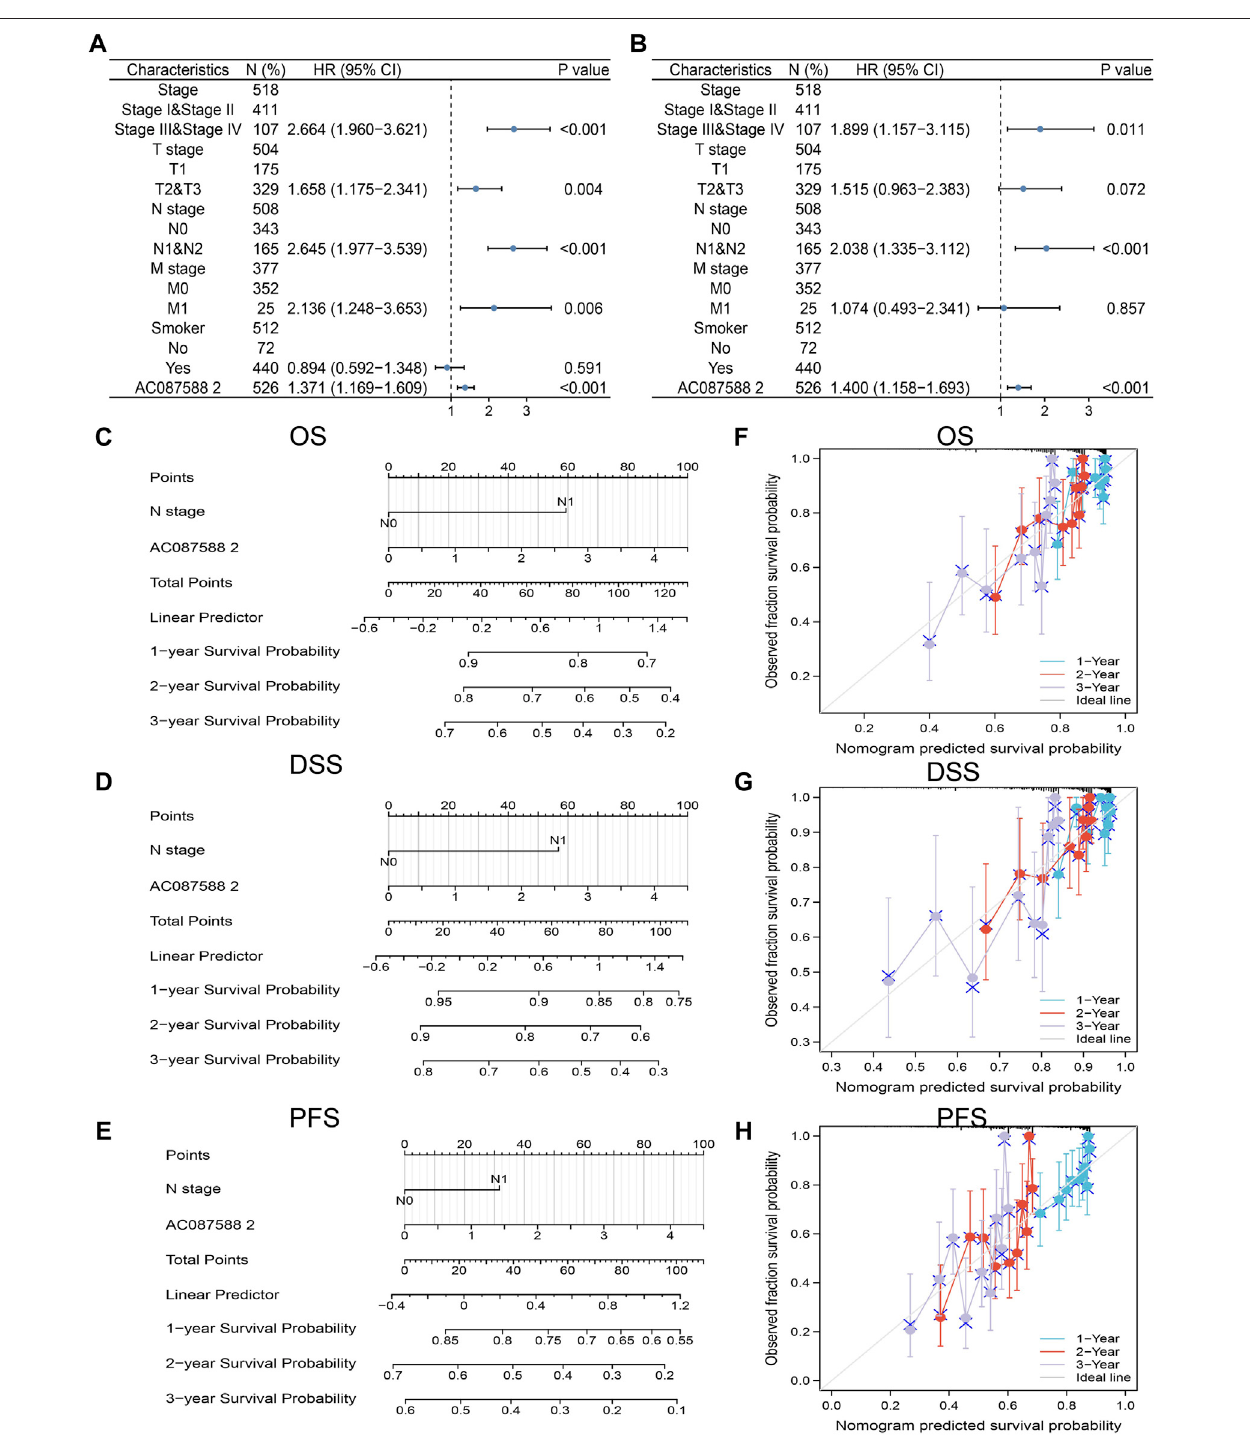
FIGURE 5 | Univariate and multivariate Cox regression analysis. (A,B) Univariate and multivariate Cox regression analysis in LUAD. (C – E) The nomogram was developed by integrating the AC087588.2 expression and T stage in the TCGA databases. (F – H) Predicting abilities of the nomogram.